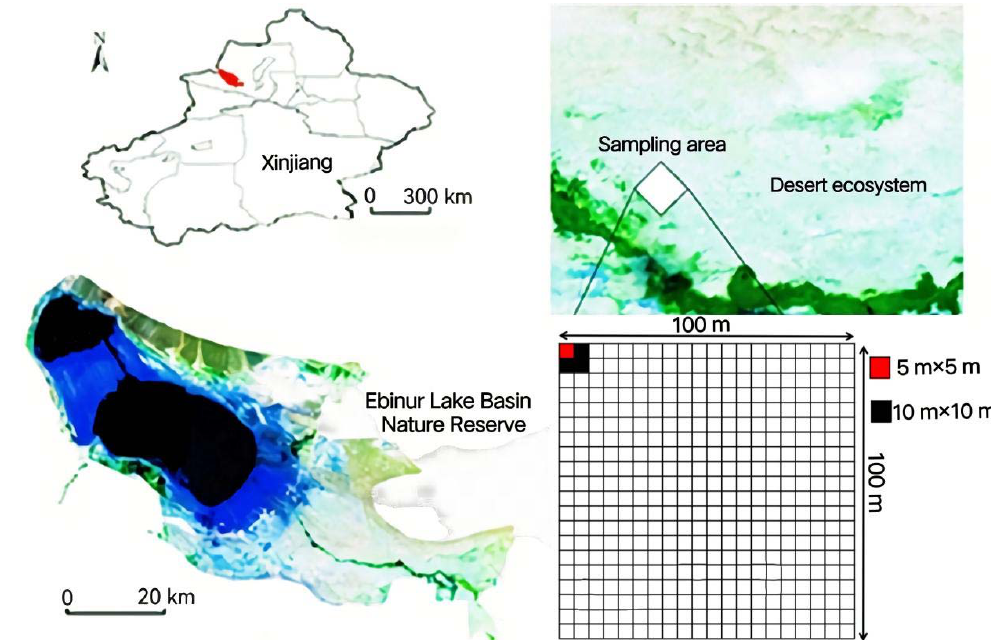
Figure 1. Layout of the sample plot.